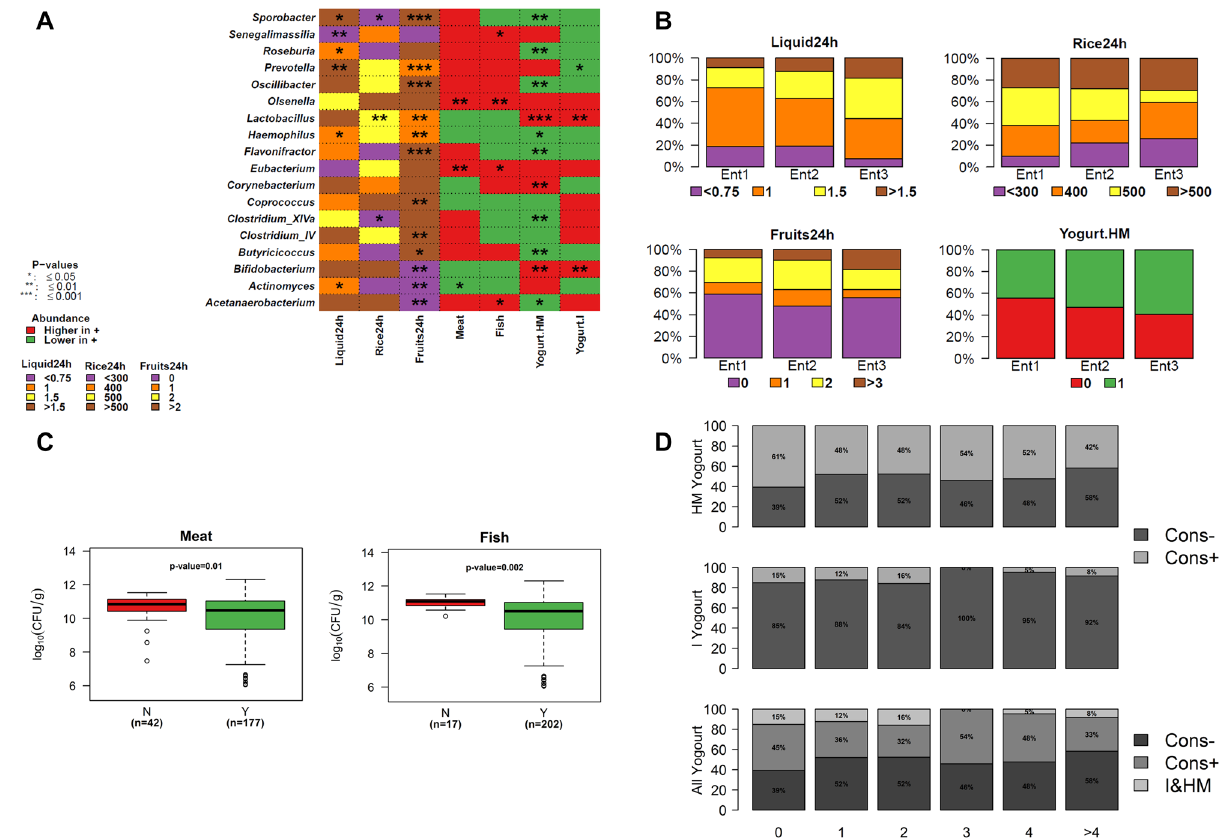
Figure 3. Impact of dietary habits on gut microbiome composition in Malagasy volunteers. ( A ) Heatmap depicting the bacterial genera having an abundance modulated by daily dietary habits. Liquid consumption is expressed in litre (L), rice in gram (g), fruits in number and other dietary information as yes/no question. Red, blue and green boxes indicate whether the abundance is higher, equal or lower in individuals positive for the listed food type. ANOVA (group > 2) and Wilcoxon test (group = 2) were run all over genera count dataset according to diet. Only boxes tagged with a star are considered statistically informative. The heatmap was generated using R software (https:// cran.r- proje ct. org/) with in-house code that uses basic functions included in "stats" and "graphics" packages. It uses genera abundance (as listed in rows) and highlights, for daily consumption of liquid, rice and fruit items, the category that are the most significantly different from others. For Meat, Fish, Yogurt-HM and Yogurt-I items, the heatmap indicates genera whose abundances are increased/ decreased in individuals consuming these items. ( B ) Proportion of individuals included in each enterotype according to food type’s consumption. ( C ) Bacterial load distribution among meat and fish eaters (Y) as compared to non-eaters (N). ( D ) Proportion of individuals eating either yogurt (Cons+) (home-made yogurt, industrial yogurt or both (I&HM)), as function of cumulative number protozoans detected in an